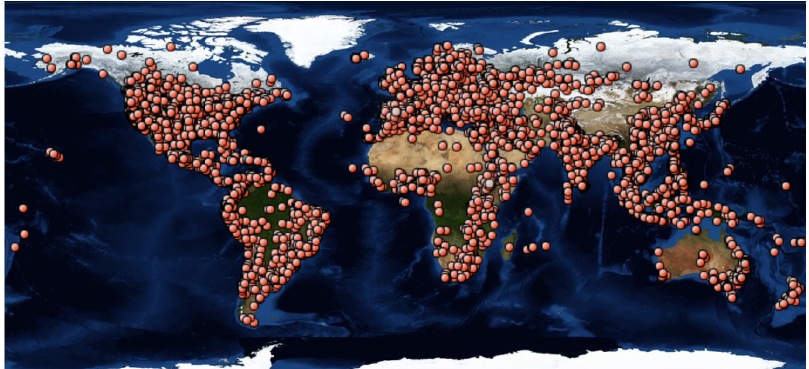
Figure 1. Origin of